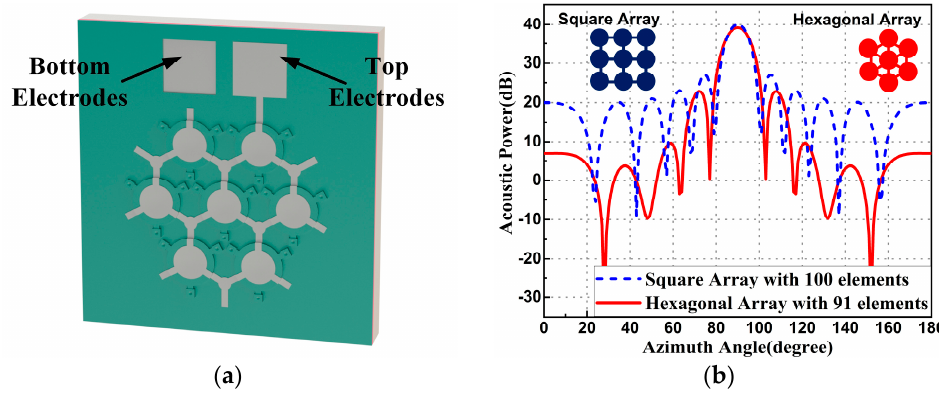
Figure 4. ( a ) Three − dimensional schematic view of a hexagonal PMUT array. ( b ) Acoustic power direction comparison between the square array and the hexagonal array.